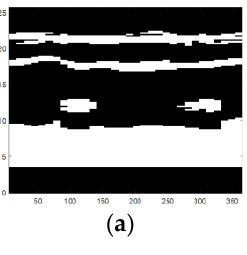
Figure 15. The defect images after removing the invalid area: ( a ) small crack, ( b ) transverse crack, ( c ) hole defect, and ( d ) chapped defect.